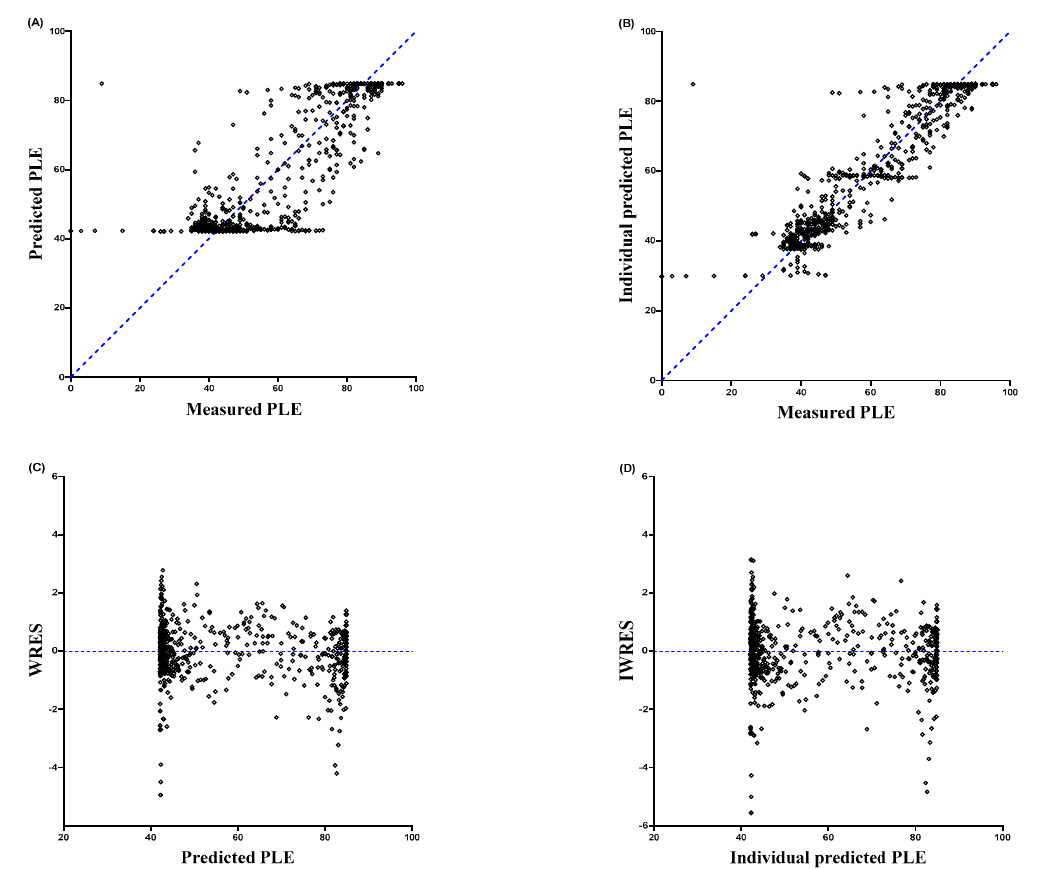
Figure 2. Weighted residual was calculated using the following equation: Weighted residual = (measured − predicted)/predicted. ( A ) predicted vs. observed phase lag entropy, ( B ) individual predicted vs. observed phase lag entropy, ( C ) weighted residuals (WRES) vs. predicted phase lag entropy, ( D ) individually weighted residuals (IWRES) vs. predicted phase lag entropy.